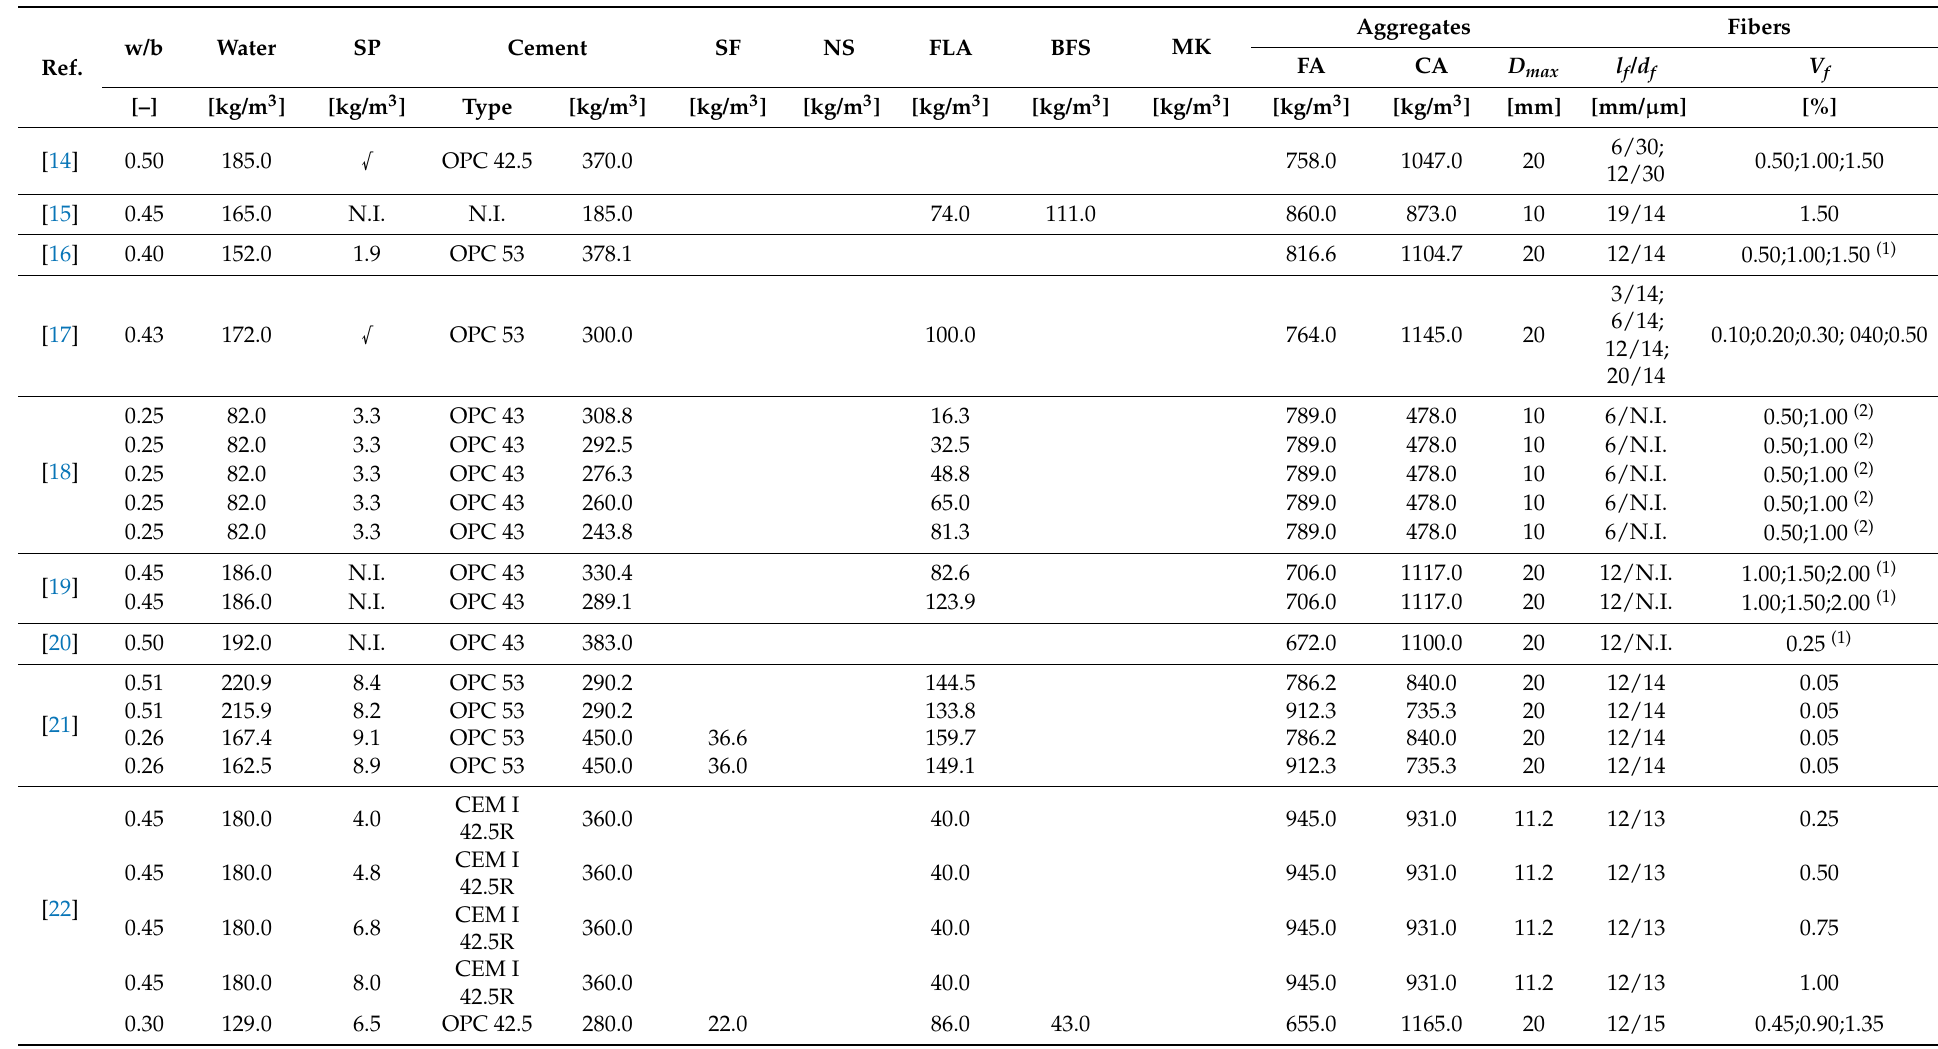
Table 3. Material composition of